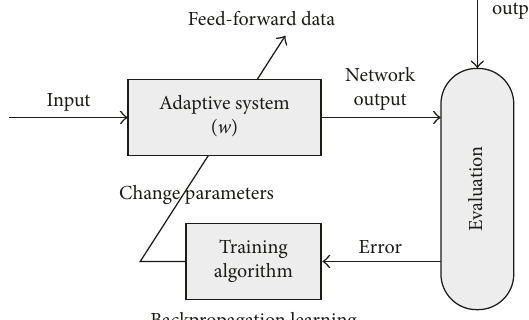
Figure 1: Neural network architecture.